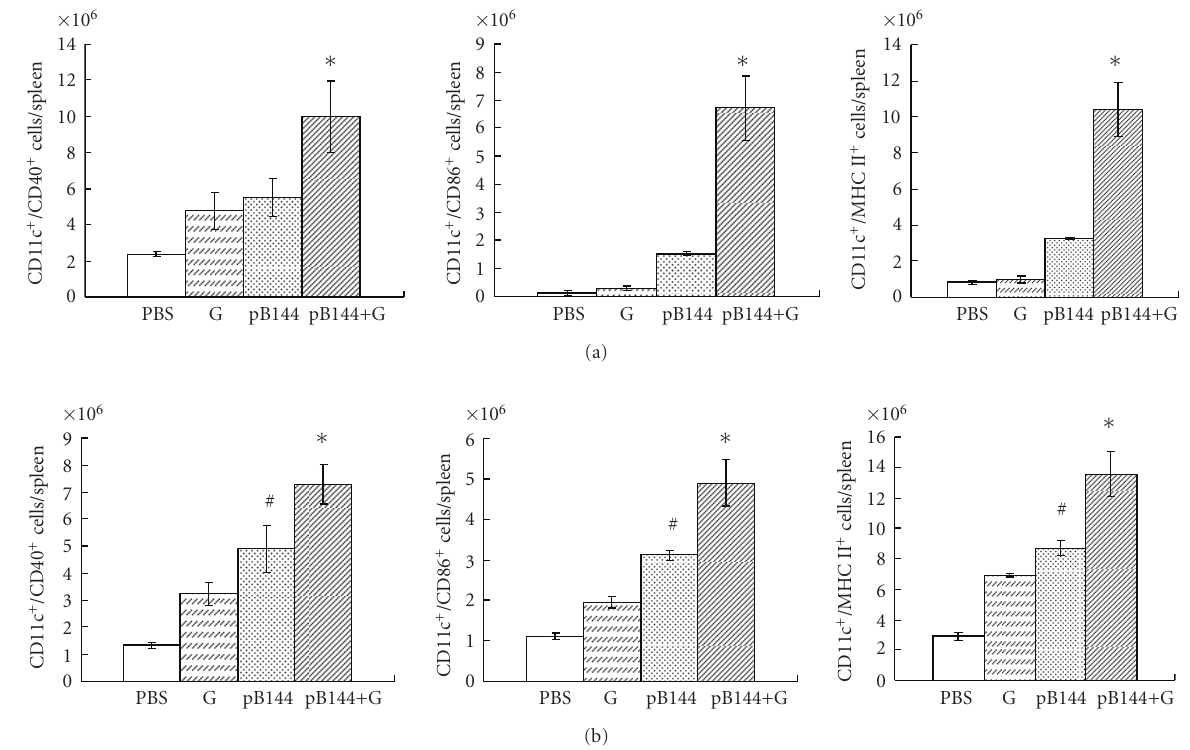
Figure 1: E ff ect of the β -glu6 on pB144-induced CD11c + DC maturation. Mice were injected in the hind leg muscle with β -glu6 (G, 1mg/kg), pB144 (100 μ g/mouse), pB144 together with β -glu6 (pB144+G), or PBS. At day 5 after priming (a) and day 5 after boosting (b), spleen CD11c + cells coexpressing CD40 (left panels), CD86 (middle panels), or MHC-II (right panels) were measured by flow cytometry. Data are expressed as mean ± SD of data from 3 mice/group. ∗ P < . 05, pB144 +G versus all other groups; # P < . 05, pB144 versus PBS